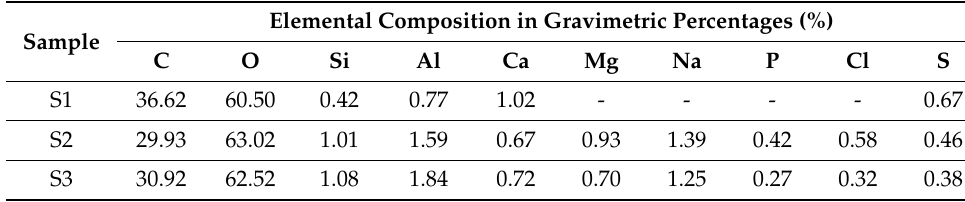
Table 1. Elemental composition of the three documents.